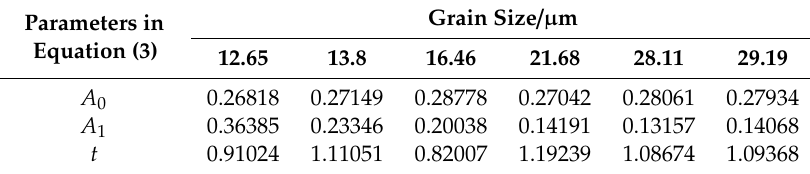
Table 1. Parameters in Equation (3) under various grain